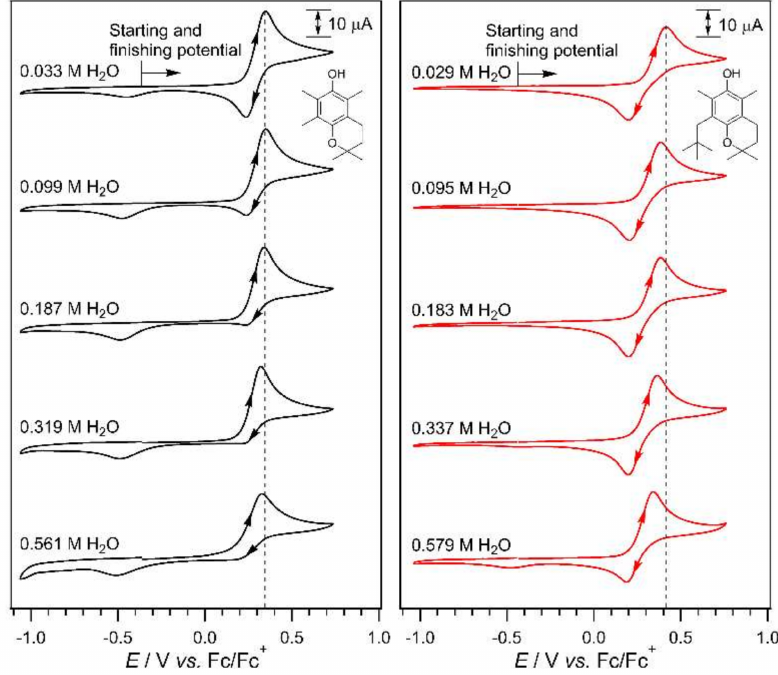
Figure 4. CVs of 2 mM of the α –tocopherol model compound [(CH 3 ) α –TOH] and neopentyl deriva- tive [(CH 3 ) α –TOH(Np)] in CH 3 CN containing 0.2 M Bu 4 NPF 6 at a 1 mm diameter circular planar Pt electrode at 22 ± 2 ◦ C at a scan rate of 0.1 V s − 1 at the specified concentration of water